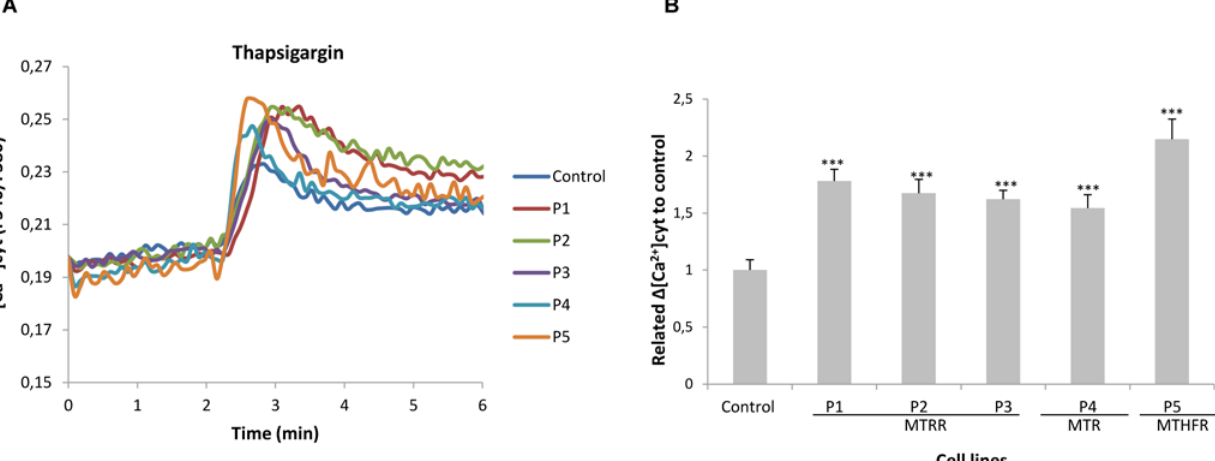
Fig 5. Levels of intracellular Ca 2+ in control and patients´ fibroblasts. (A) Representative recording showing levels of intracellular Ca 2+ prior to and after exposure of patients and control to 1 μ M thapsigargin (Thap). (B) Quantitative data from three different experiments showing the peak amplitude of the Thap- induced rise in cytosolic Ca 2+ in patients and control fibroblasts. Data represent mean ± SEM (standard error of the mean = SD/